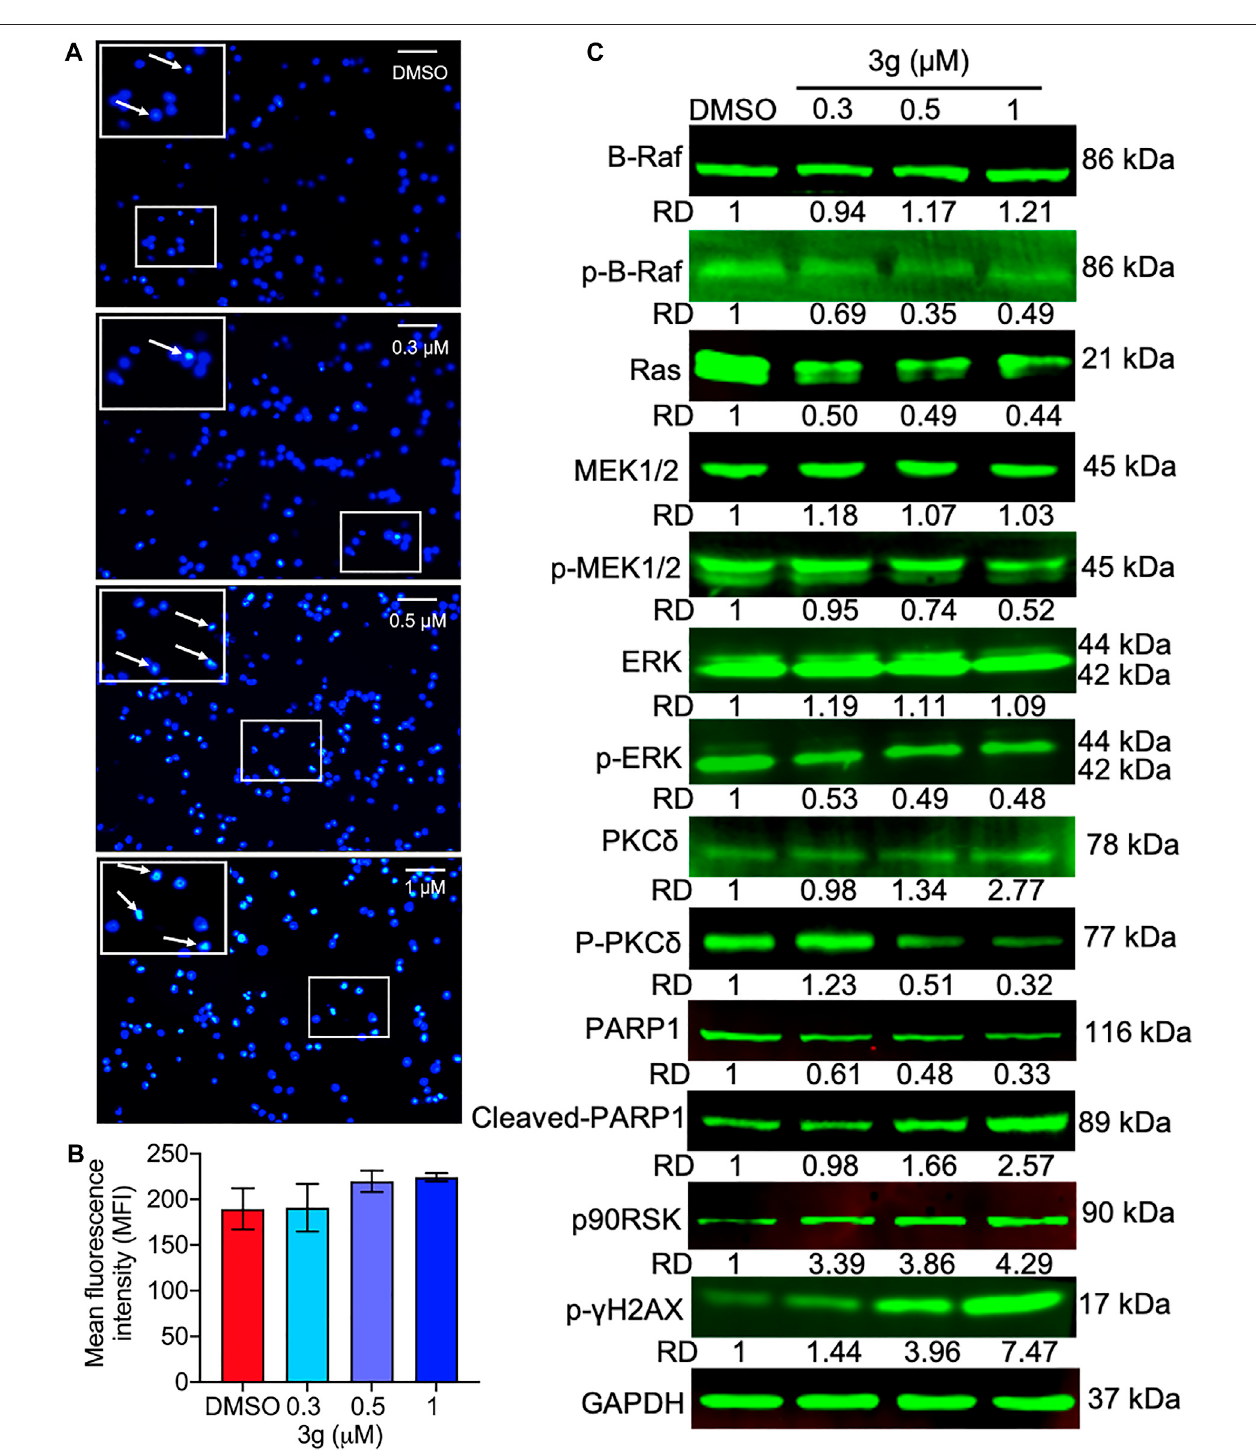
FIGURE5 | DNA damage and the Ras/Raf/Mek/Erkpathway alterations induced by3g in K562 cells. (A) Photomicrograph ofDNA damage (in boxes) at indicated concentrations of 3g treatment. (B) Quanti fi cation of the fl uorescence levels showing extent of DNA damage. (C) Protein expression levels of indicated proteins after 3g treatment at 48